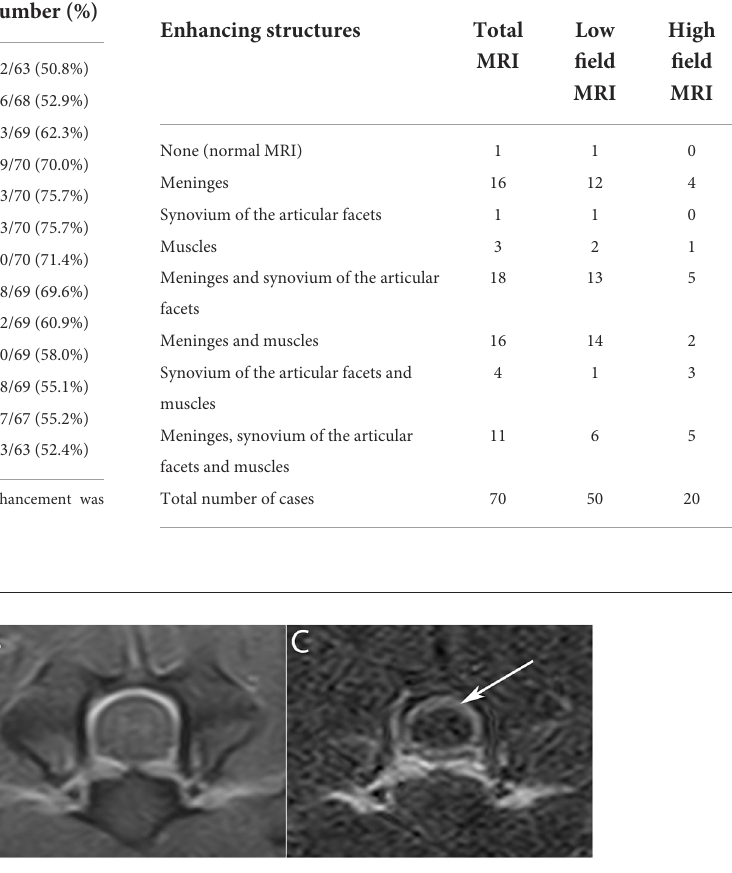
FIGURE2 Subtraction technique in the detection of meningeal enhancement. (A) Pre- and (B) post-contrast transverse T1W image at the level of the C5–C6 intervertebral space. After subtraction (C) , a subtle meningeal enhancement not easily detectable in (B) is seen